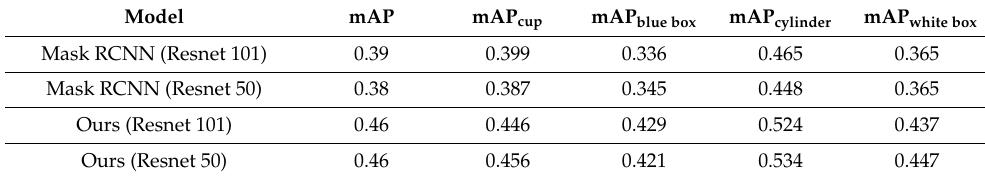
Table 2. Mean average precision of our approach in comparison to original Mask